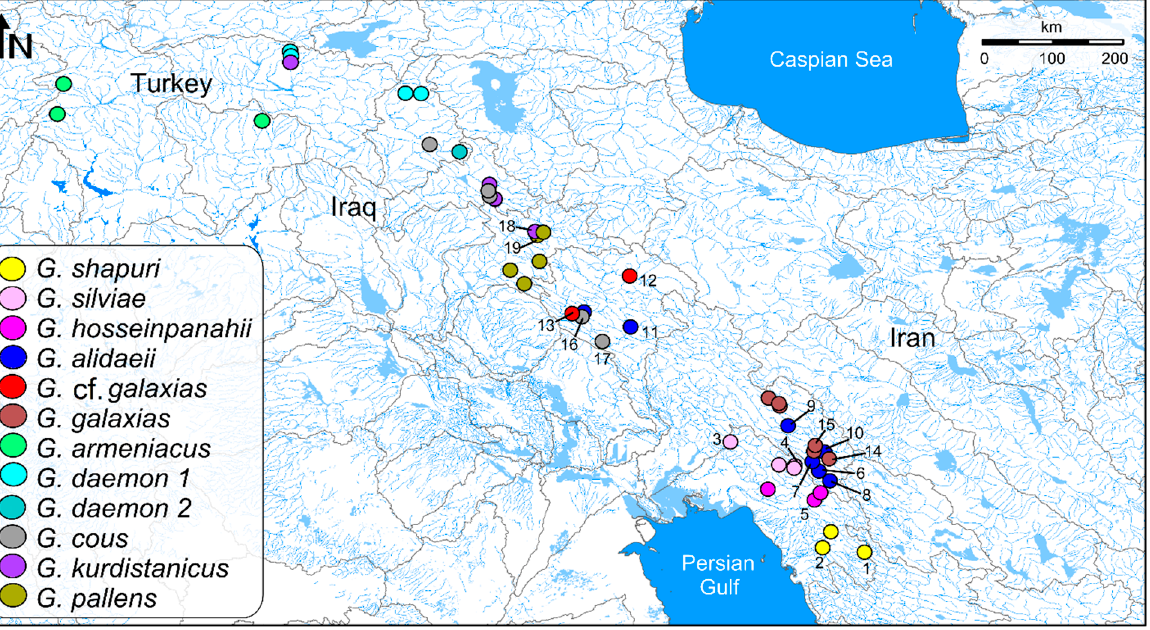
Figure 1. Records of Glyptothorax spp. from the Middle East used in this study. The location codes (new localities from Iran) correspond to those in Table 1. Un-numbered localities refer to those from Freyhof et al. [4] and Mousavi-Sabet et al. [5]. The map was originally designed in DIVA-GIS 7.5 (https://www.diva-gis.org/) (accessed on 28 February 2022). Morphometric measurements were made with a dial calliper and recorded to 0.1